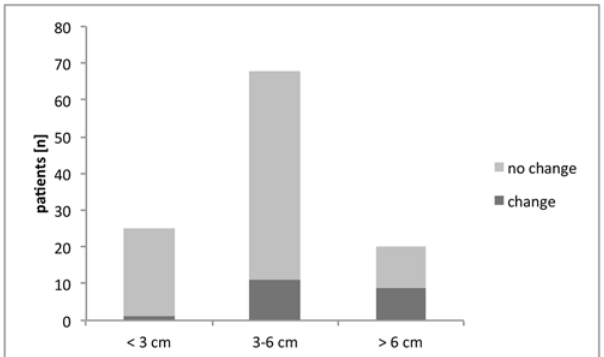
Fig 2. Distribution of change of treatment on ICU patients dependent on tumor size. Patients were assigned to the indicated groups dependent on meningioma size. Tumor size of > 6 cm is significantly more often associated with a change in postoperative treatment compared to a tumor size of < 3 cm (p < 0.005) and 3 – 6 cm (p < 0.05, Fisher ’ s exact